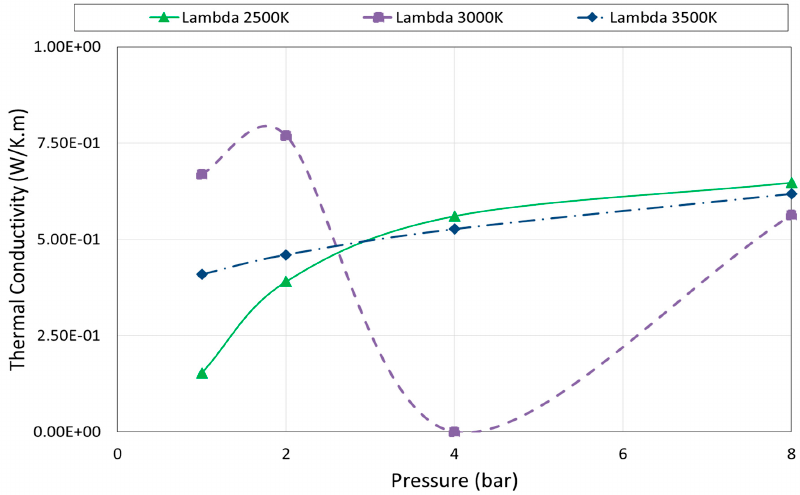
Figure 7. Discharge thermal conductance versus pressure for different temperatures.